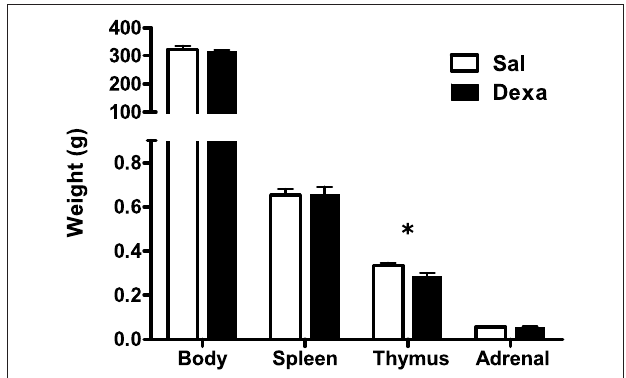
FIgure 1 | Prenatal treatment with dexamethasone induces decreased thymic weight in adulthood. Body, spleen, thymus, and adrenal glands weight were measured at 3 months of age in rats prenatally treated either with saline or with dexamethasone. Each bar represents the mean + SEM, from eight to nine rats per group from one of four independent experiments.